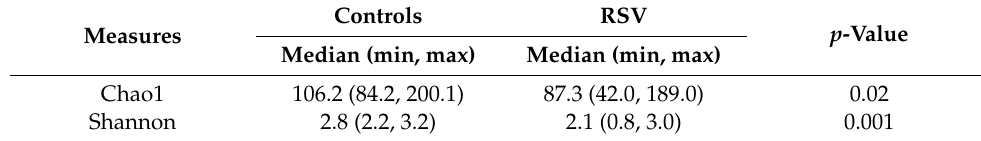
Table 3. Alpha diversity of the gut microbiota for all infants at a single timepoint.